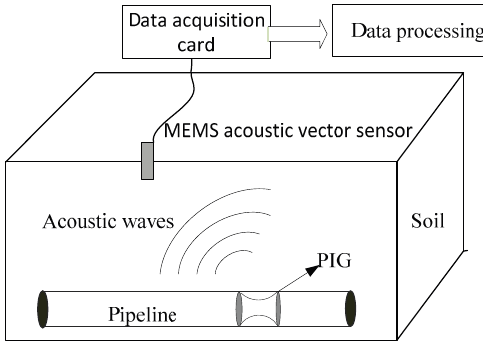
Figure 8. The positioning principle of the PIG based on a MEMS acoustic vector sensor.